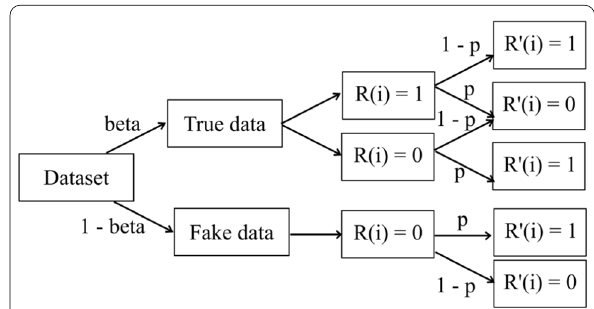
Fig. 2 The probabilities associated with the use of RAPPOR as a privatization